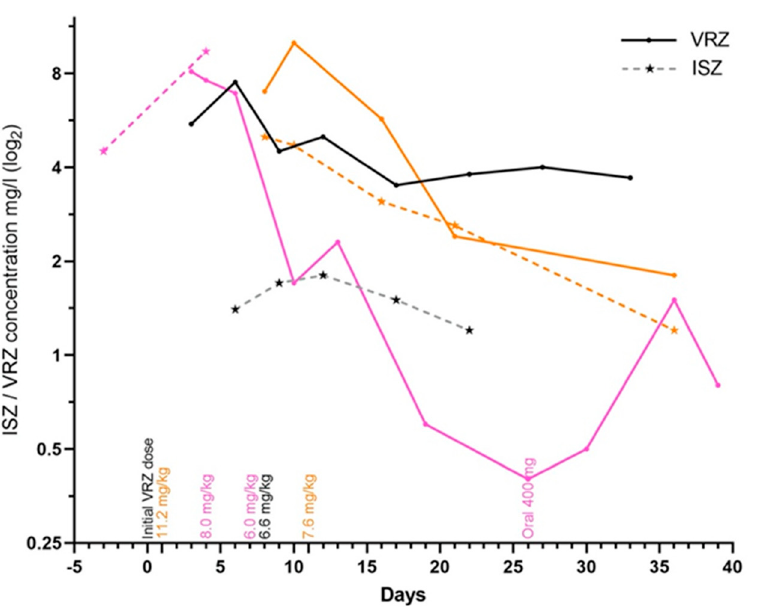
Figure 3. Three patient cases who during antifungal treatment switched from ISZ to VRZ. On day 0 the patients discontinued ISZ and began VRZ instead. Filled circles connected with solid lines represent serum concentrations of VRZ while asterisks connected with dashed lines represent serum concentrations of ISZ. The s-VRZ concentrations are plotted up to the first 39 days after the initial dose. The patient represented in pink received an initial VRZ dosage of 6 mg/kg twice a day. Day 4, 4 mg/kg twice a day. Day 7, 3 mg/kg twice a day. Day 26, switched to oral intake 200 mg twice a day. The patient represented in black received an initial VRZ dosage of 4.5 mg/kg twice a day. Day 8, 3.3 mg/kg twice a day. The patient represented in orange received an initial VRZ dosage of 7.5 mg/kg twice a day and had also received statins until two days after initiating ISZ. Day 1, VRZ dosage 5.6 mg/kg twice a day. Day 11, 3.8 mg/kg twice a day. None of the three patients received calcineurin inhibitors.